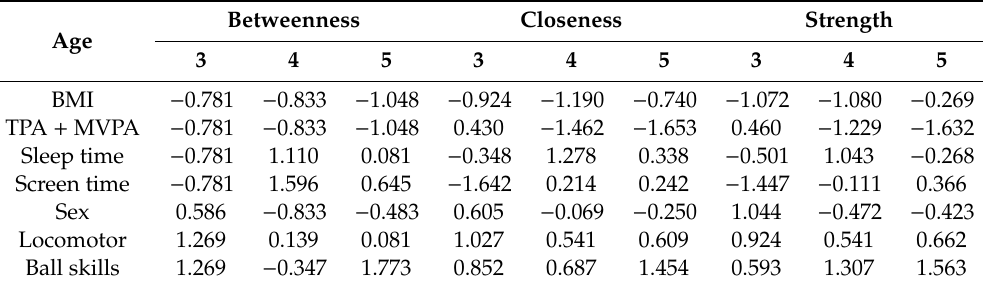
Table 3. Centrality measures.